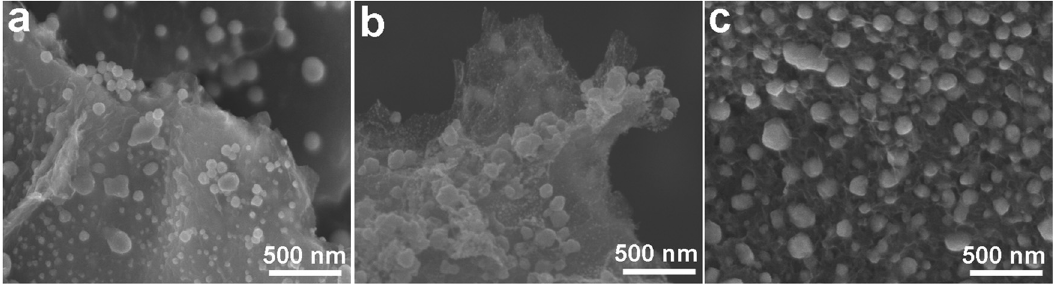
Figure 1: SEM images of McM@rGO synthesized at di ff erent annealing temperatures: ( a ) McM@rGO - 400, ( b ) McM@rGO - 600, and (